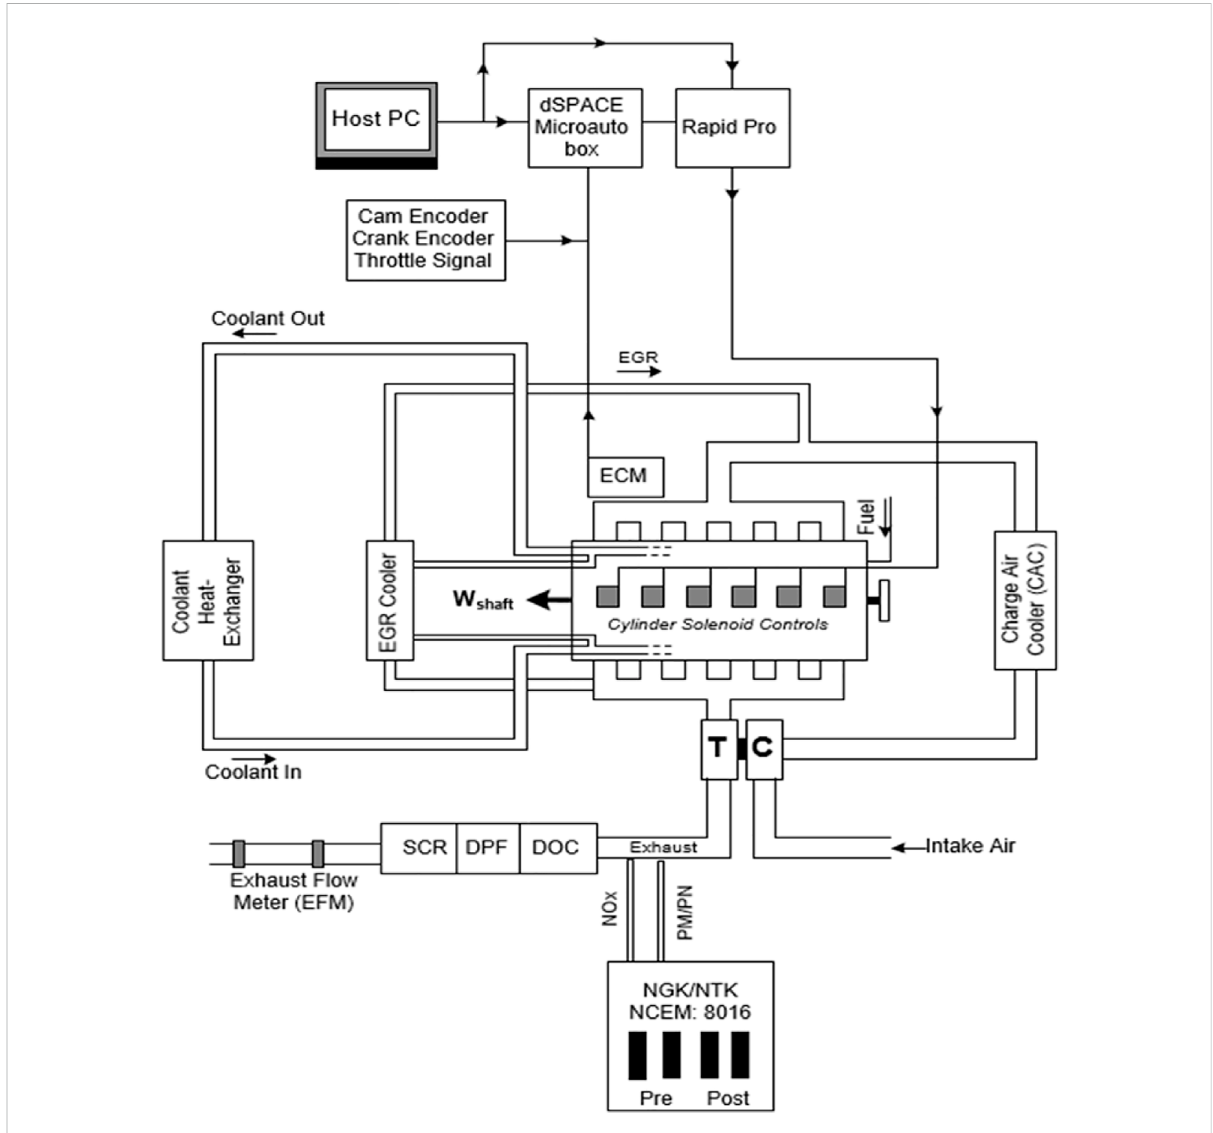
FIGURE 1 Engine instrumentation